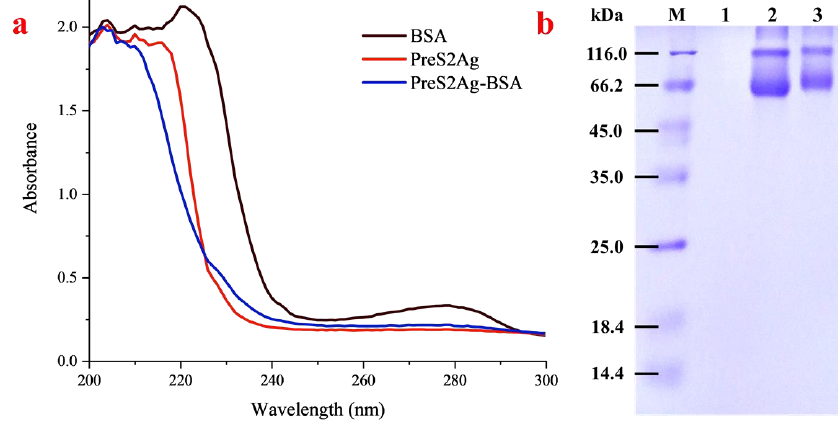
Figure 2. Characterization of conjugated antigen. ( a ) UV absorption spectrum. ( b ) SDS-PAGE. M: Marker; 1: preS2Ag; 2: BSA; 3: preS2Ag-BSA.